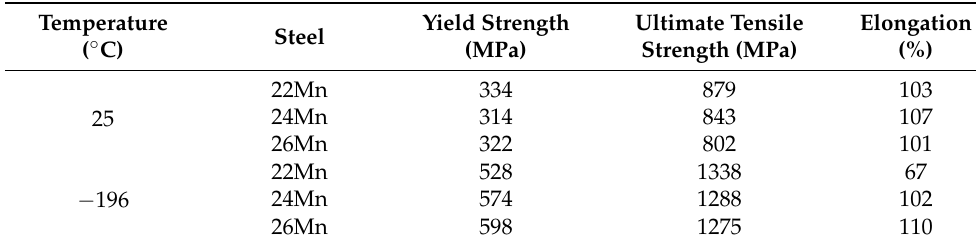
Table 3. Mechanical properties of Fe–0.4C–(22–26)Mn steel at room temperature and − 196 ◦ C (Reprinted with permission from Ref. [9], Copyright 2022